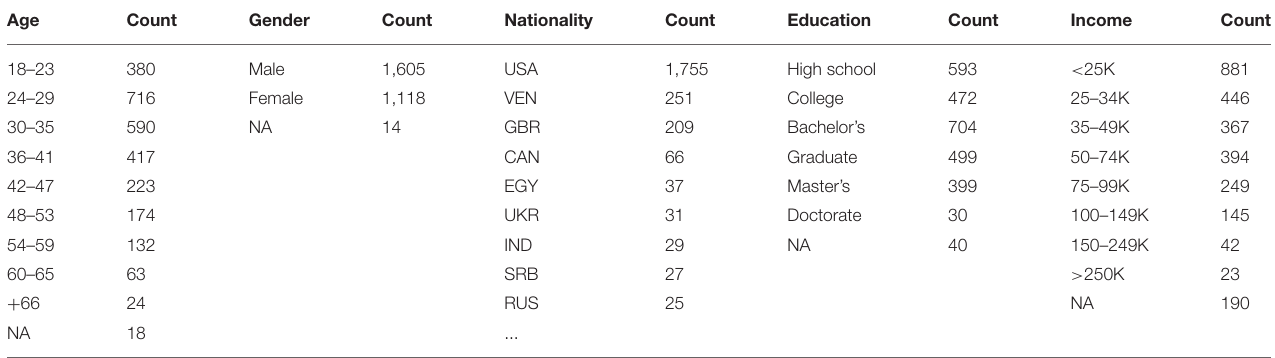
TABLE 1 | Demographics information from our